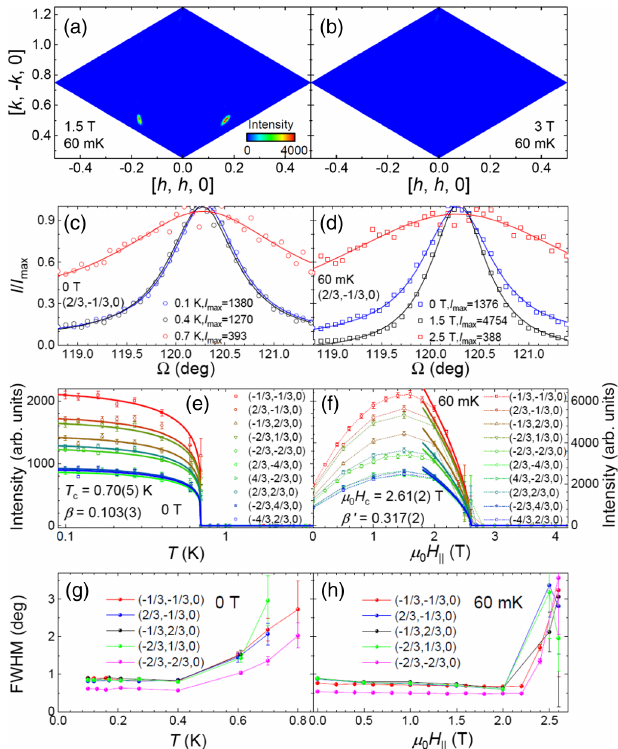
FIG. 12. Magnetic neutron diffraction of TmMgGaO4 mea- sured on D23 at 60 mK under the magnetic field of (a) 1.5 T and (b) 3 T, applied along the c axis. Selected Ω scans measured on ; − 1 ; 0 Þ magnetic reflection (c) at 0 Tand (d) at 60 mK. The the ð 2 3 3 colored lines show the corresponding Lorentzian fits. (e) Temper- ature and (f) magnetic field dependence of the magnetic reflection intensities measured at 0 T and at 60 mK, respectively. The colored lines show the combined critical fits. (g) Temperature and (h) magnetic field dependence of the magnetic reflection FWHM measured at 0 T and at 60 mK, respectively.